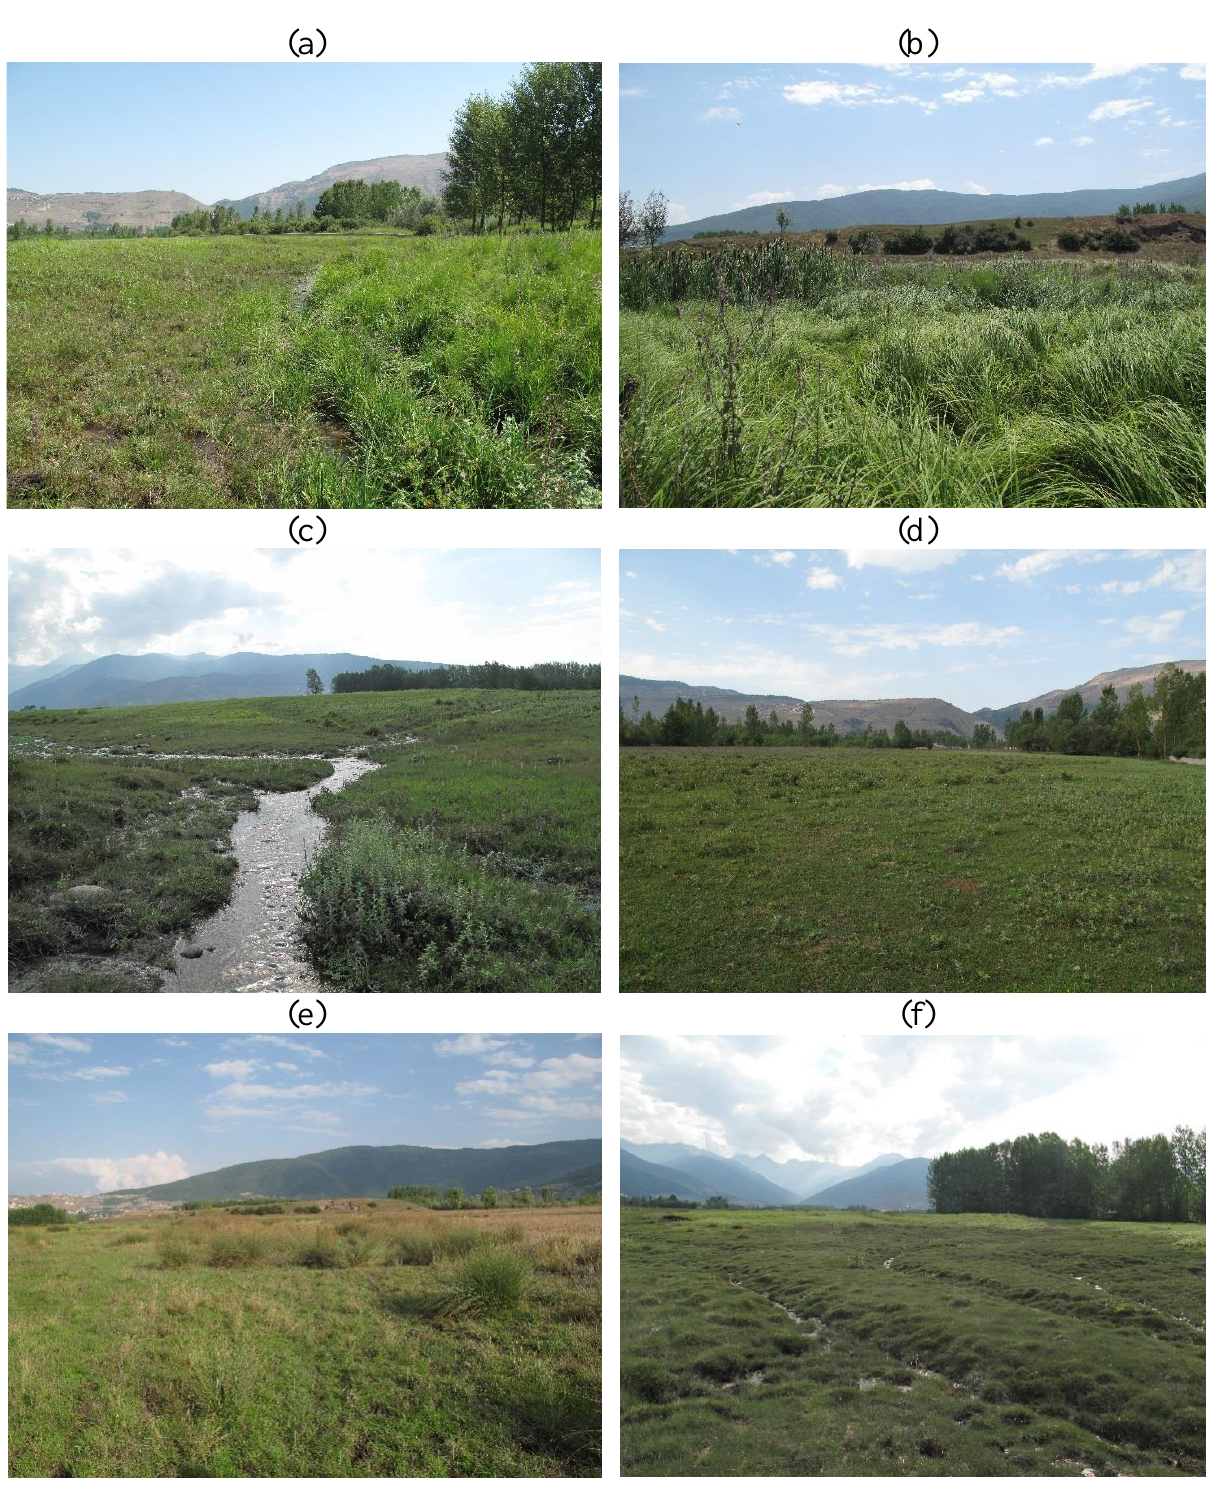
Figure 3. The six habitat types distinguished on Chaman-e Kelar Mire, Central Alborz Mountains, Iran. (a): WC = patches of Carex orbicularis on wet peat hummocks; (b): PD = peaty depressions with stagnant surface water; (c): BR = brooklets; (d): DH = dry hummocks; (e): WM = wet meadows; (f): WP = loose watery peat patches along the